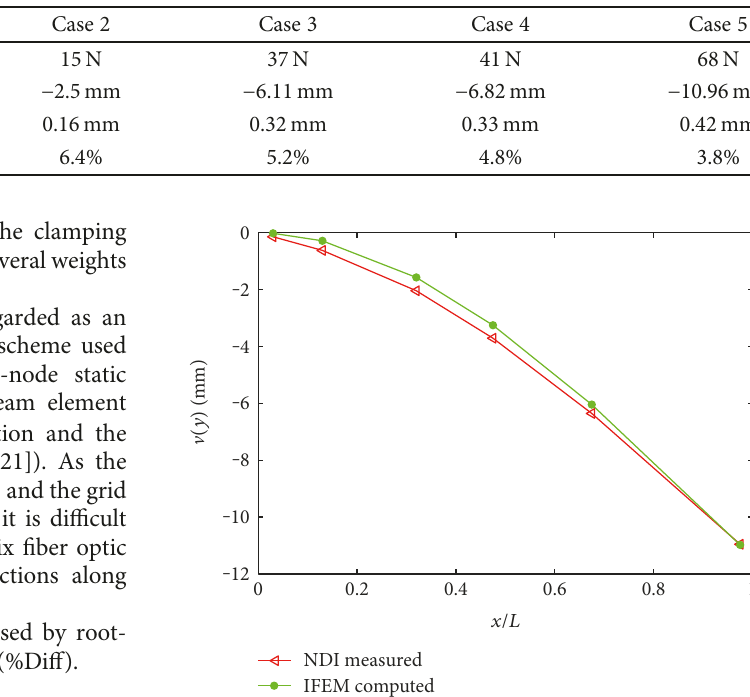
Table 2: Loading case for the clamped-free beam. Max de fl ections are captured from NDI.